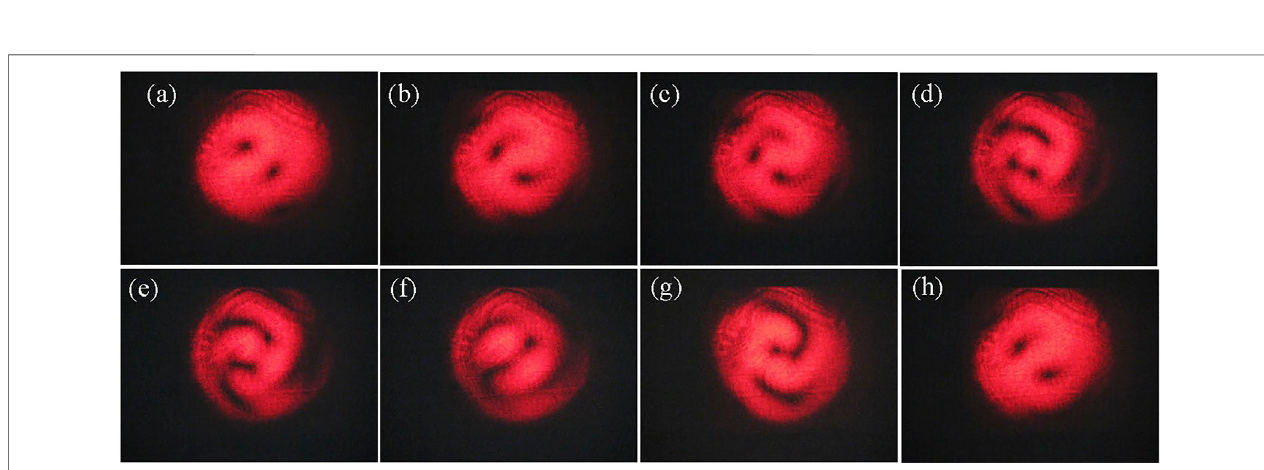
Frontiers in Physics |